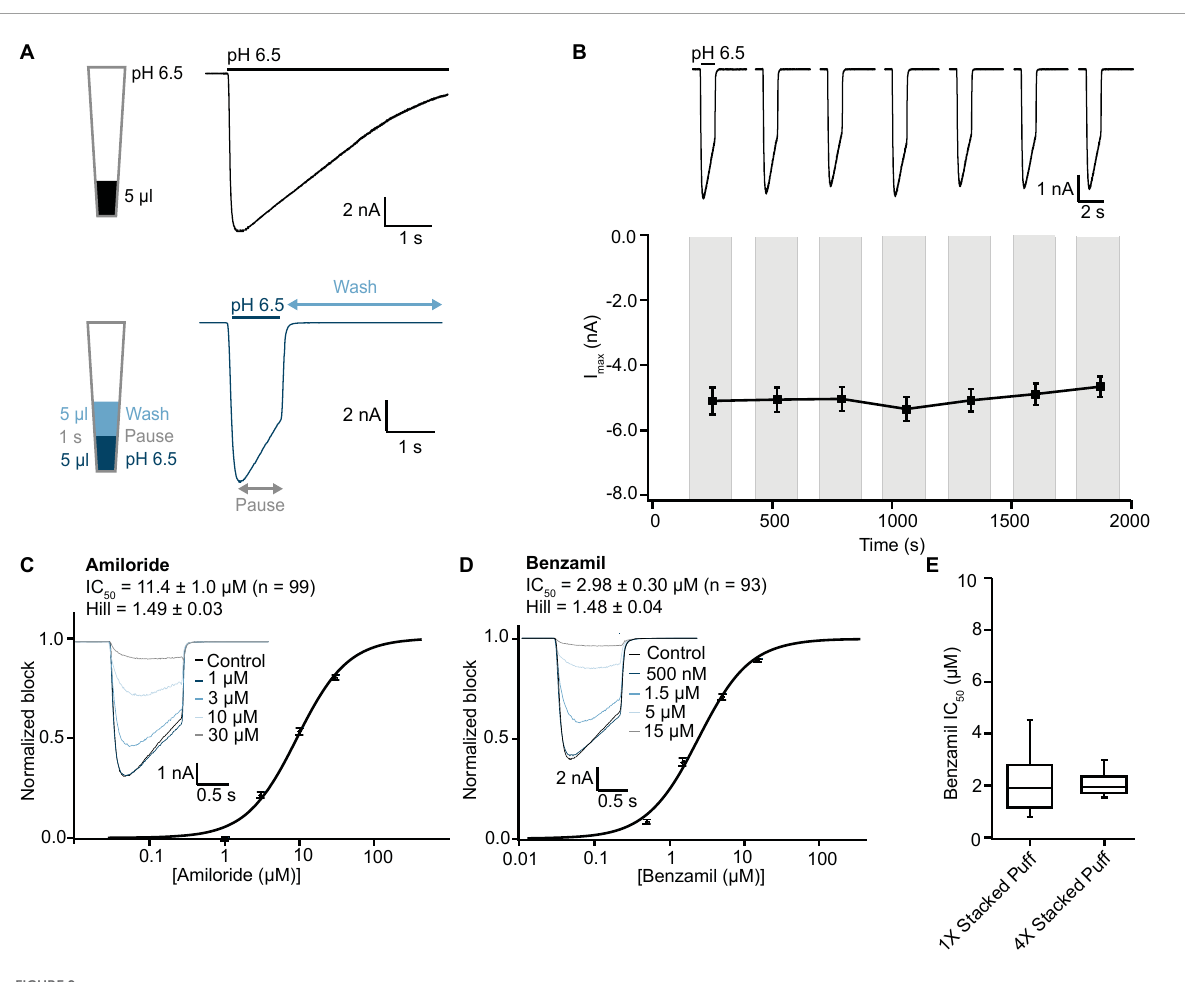
FIGURE9 Validation of ASIC1a stacked tip assay format on SP384i. (A) Comparison of “puff” ligand application versus “stacked puff” format. Top left shows a schematic of the “puff” solution in the pipette tip and corresponding example of ASIC1a-mediated current with slow desensitizing phase. Bottom left shows the schematic of the “stacked puff” solutions in the pipette and an exemplar ASIC1a-mediated current with slow desensitization followed by rapid wash-off. (B) Stable responses in a single hole well to repeated “stacked puff” applications of pH 6.5 (top), and average current stability data from n = 48 wells (bottom; mean ± S.E.M). (C,D) Inhibition of ASIC1a responses using “stacked puff” approach by Amiloride and Benzamil with single hole chips. Raw current traces (insets) in response to pH 6.5 “stacked puff” activation after pre-incubation in indicated concentrations of drug enable construction of cumulative IC 50 curves for Amiloride (C) and Benzamil (D) , with indicated mean, S.E.M and n values, and Hill slopes of 1.49 and 1.48, respectively. (E) There is a wider spread of IC 50 values for Benzamil for 1X chips compared with 4X chips using the “stacked puff” application of ligand, although the mean values were not statistically different ( P > 0.05, unpaired Student’s t